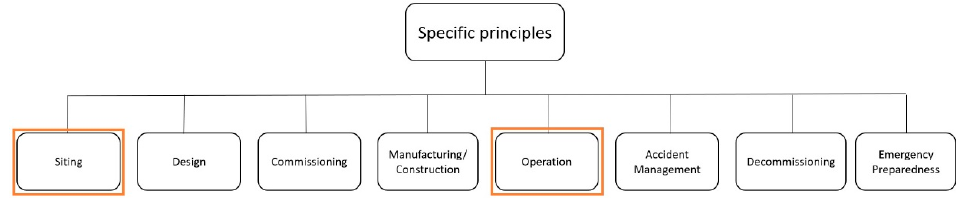
Figure 2. Structure of specific